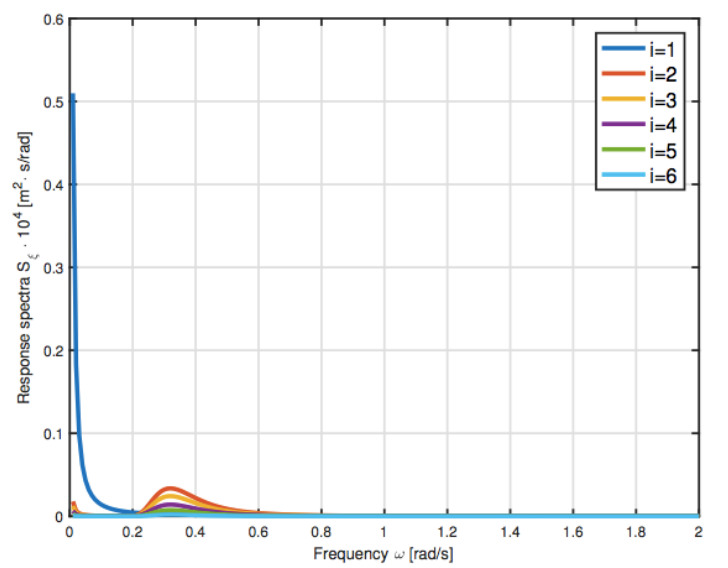
Figure 25. Response spectra for the displacements in physical coordinates of the 2-MW offshore wind turbine